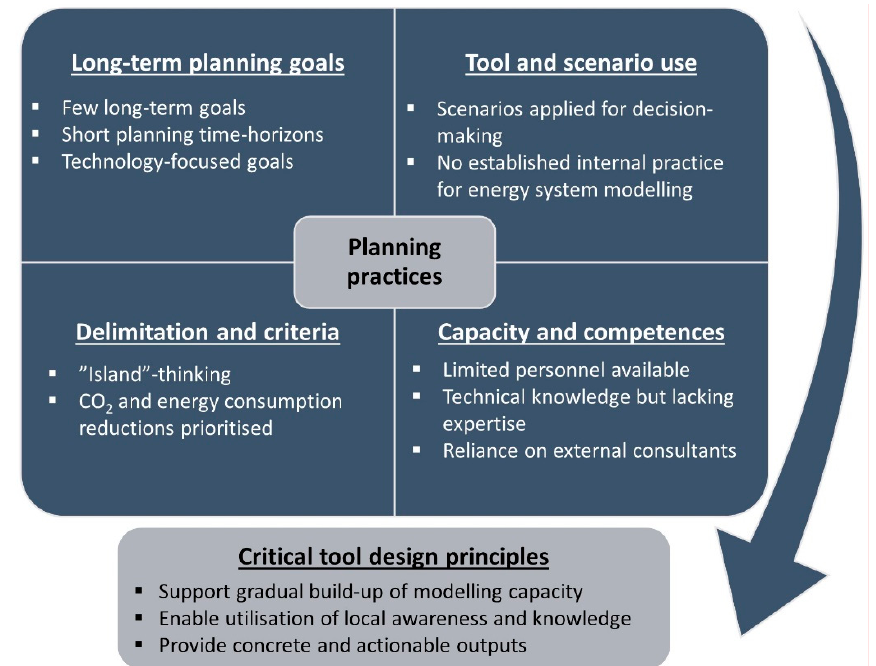
Figure 2. Main findings summarised.